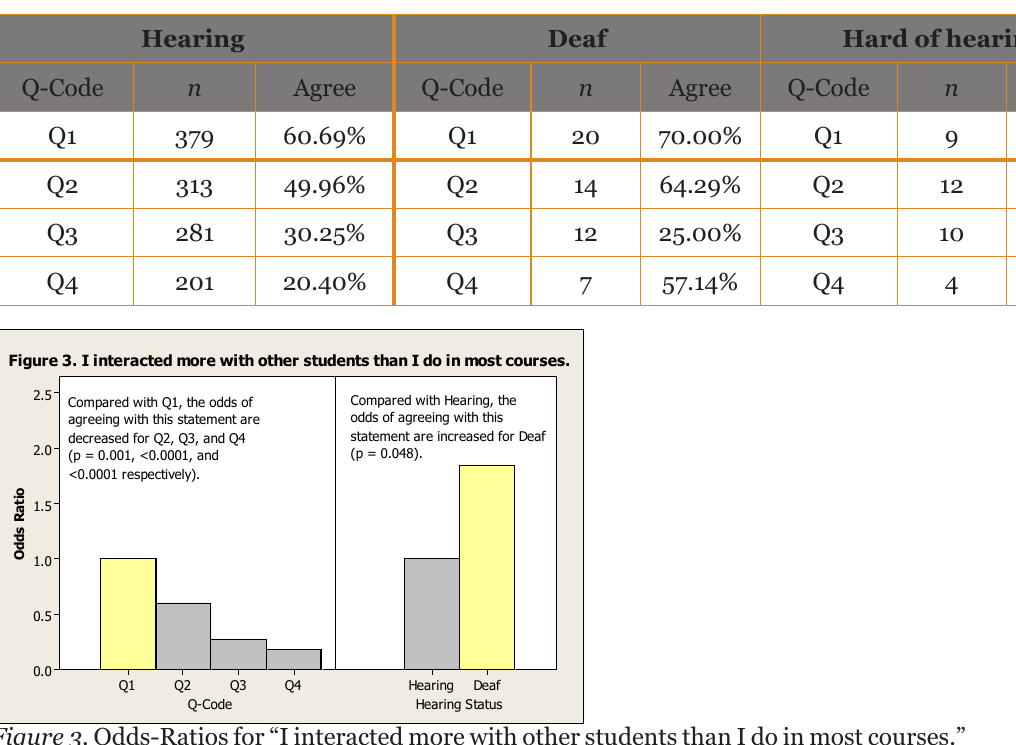
The following findings were found for “improved ability to communicate my ideas because of the online interaction in this course” (Table